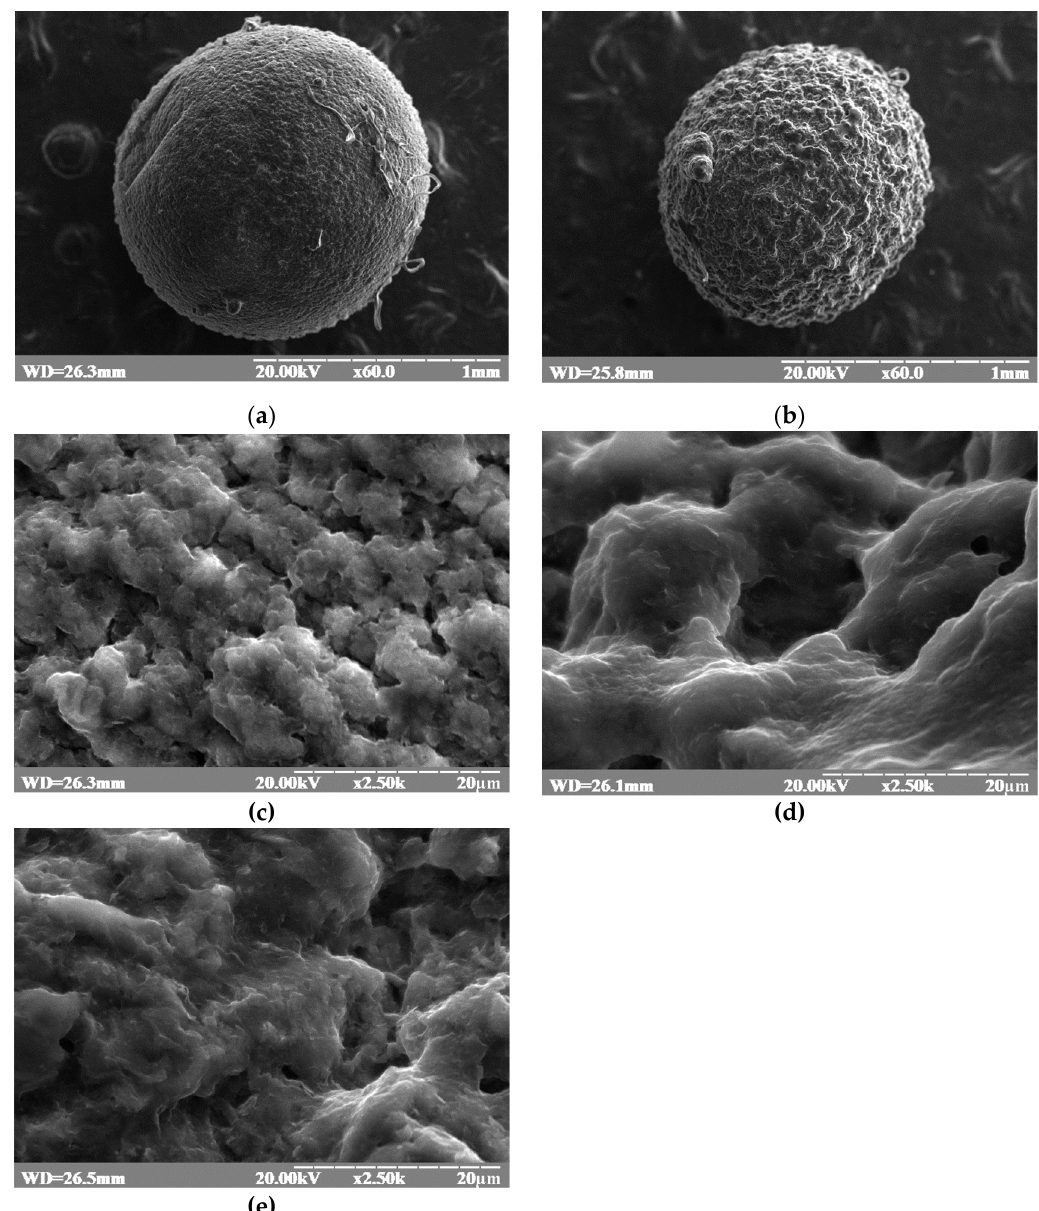
Figure 1. Scanning electron microscopy of calcium alginate beads. ( a ) A total of 4.5% alginate bead without copper, magnified 60 times; ( b ) 20.3% alginate bead without copper magnified 60 times; ( c ) higher magnification (2500 times) of 4.5% alginate bead without copper; ( d ) higher magnification (2500 times) of 20.3% alginate bead without copper (an air pocket in the dark area is visible); and ( e ) 20.3% alginate bead loaded with copper magnified 2500 times.